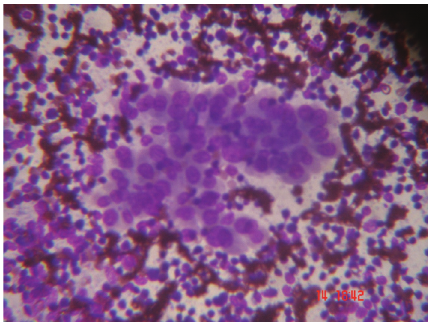
Figure 2: Numerous oxyphilic epithelial cells (Askanazy cells), moderate to large number of lymphocytes in a hemorrhagic background seen in thyroid tissue of woman presenting with Hashimoto’s thyroiditis (May-Grunwald-Giemsa stain; original magnification 450, reduced by 30%). Table 2: Saliva CRP Levels in HT, SAT, and Control Groups. Group CRP Levels μ g/L Hashimoto’s thyroiditis ( n = 30) 0 . 817 ± 0 . 206 a 1 . 908 ± 0 . 752 cb 0 . 837 ± 0 .